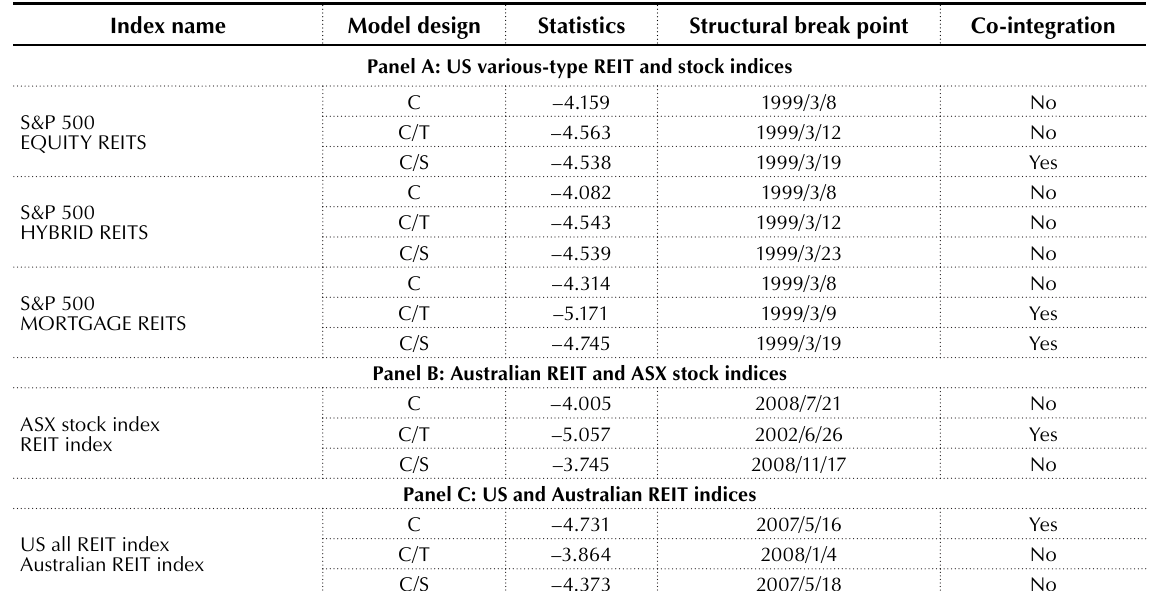
Panel B: Australian REIT and ASX stock